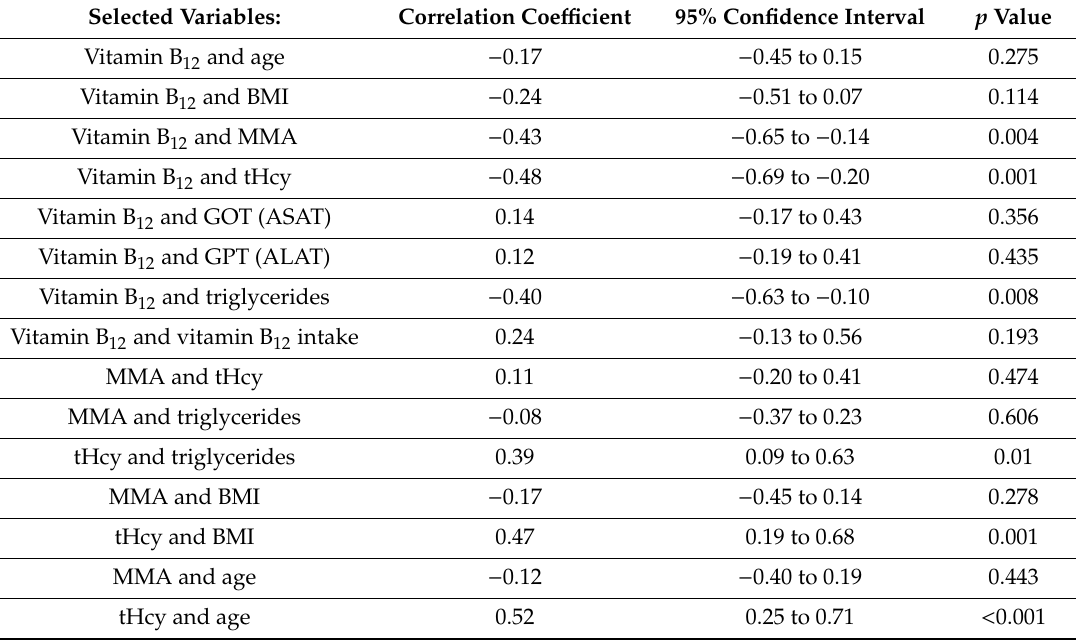
Table 4. Correlation analyses in GSD patients. Correlations were tested using the Spearman’s rank correlation coe ffi cient. The significance level was set to α =